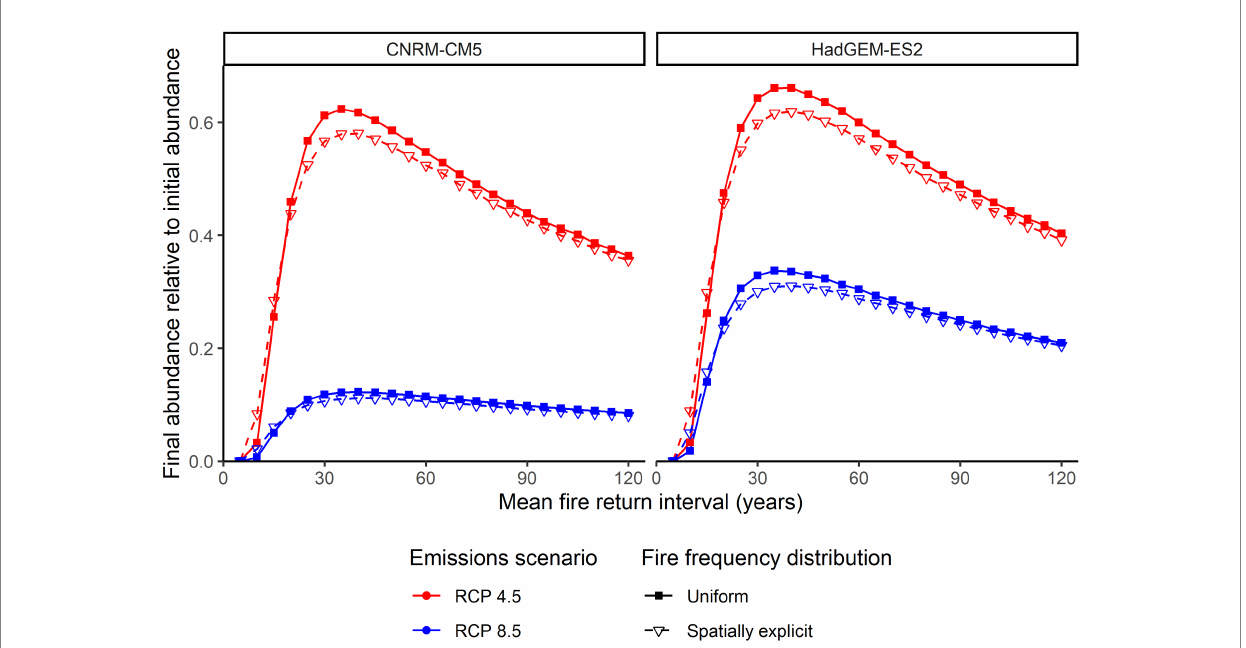
FIGURE 2 Final abundance of the total metapopulation relative to the initial abundance of the total metapopulation across different mean fire return intervals. Color represents different emissions scenarios in the climate model, left/righ represents different climate models, and symbol represents how fire frequency was distributed around the